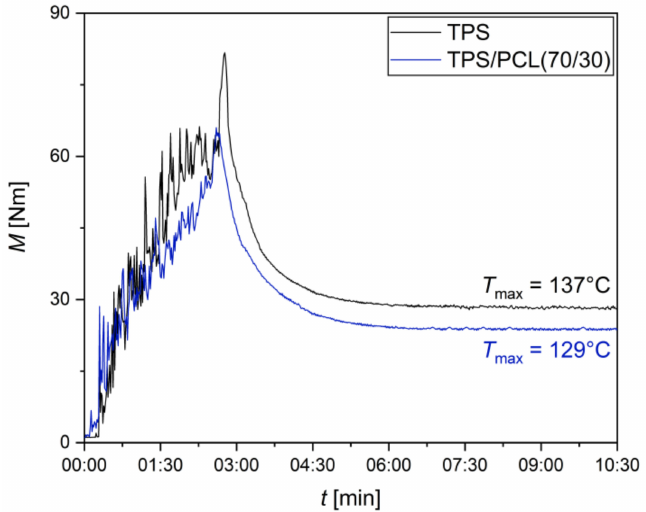
Figure 2. Torque moments as a function of melt-mixing time and maximum temperatures during melt-mixing of neat TPS (black line) and TPS/PCL (70/30) blend (blue line). The initial increase of the torque moments corresponds to the filling of the mixing chamber, which was heated to 120 ◦